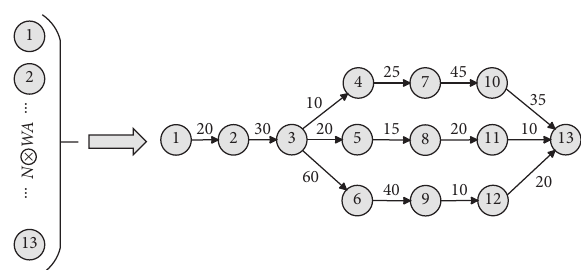
Figure 3: Composition of multiconstraint workflow